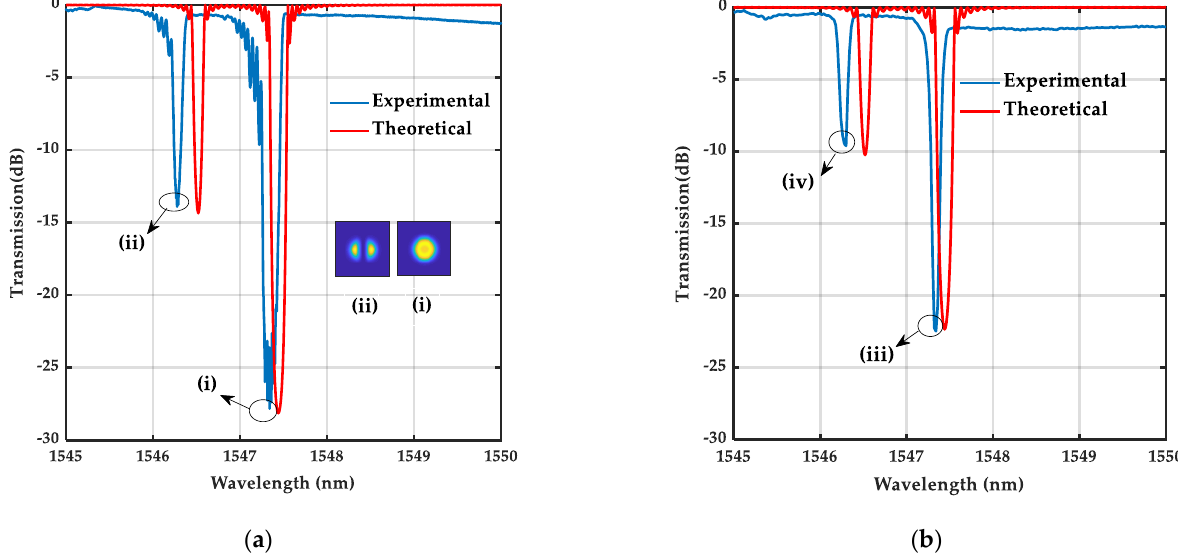
Figure 4. The conversion efficiencies of the ( a ) LP 01 mode and ( b ) LP 11 mode versus attenuation coefficient α and grating amplitude χ under LP 01 mode excitation (red lines ( i ) and ( ii ) are contour lines of 0.9983 and 0.9593, respectively).